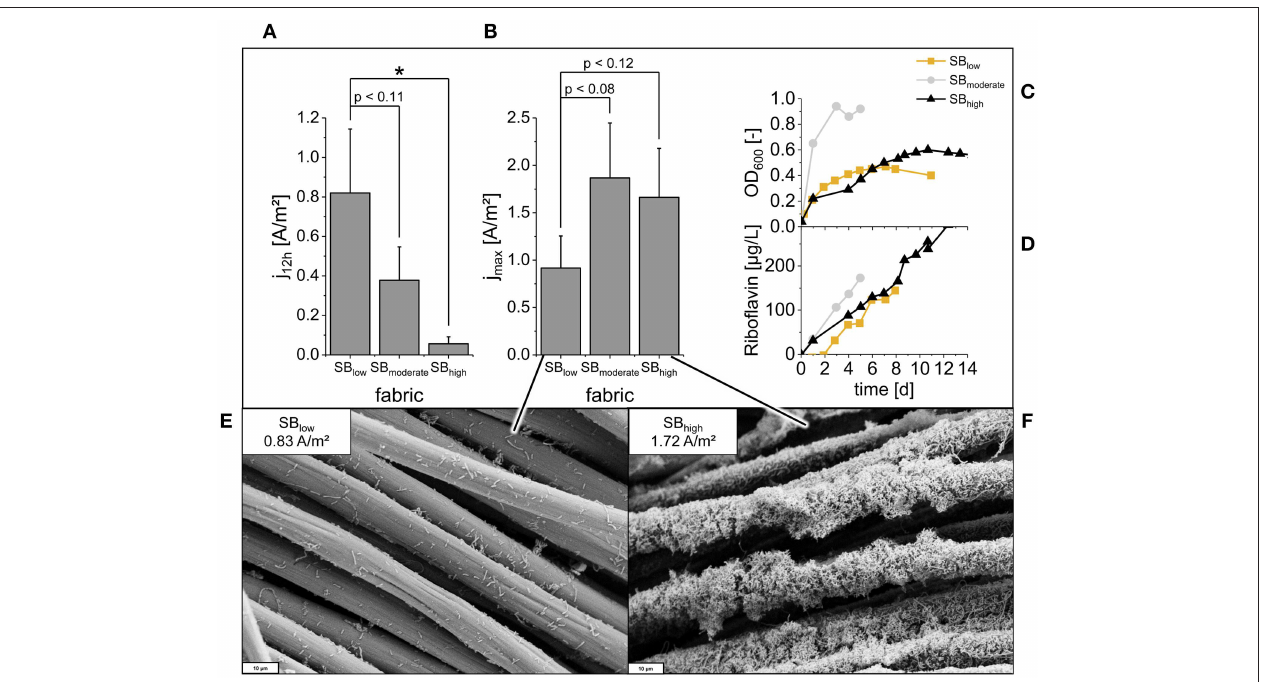
FIGURE 5 | (A) Maximum current densities j max , (B) startup current density j 12h (both normalized to 2D projected surface area), (C) examples for planktonic growth, and (D) riboflavin production achieved with fabric electrodes made from stretch-broken yarn (SB) with increasing carbon contents (low, moderate, high). (A,B) Are average values and standard deviations from triplicates (C,D) , are representative single experiments. Asterisks mark significance levels of p < 0.05 (two-sampled t -test), other p- values lower than 0.12 are also given. (E,F) : SEM images of example fabrics SB low /SB high , which were taken after 15 days from reactors sharing identical inocula; scale bars = 10 µ m. Current density values displayed in images (E,F) correspond to the sampling time point (end of experiment).